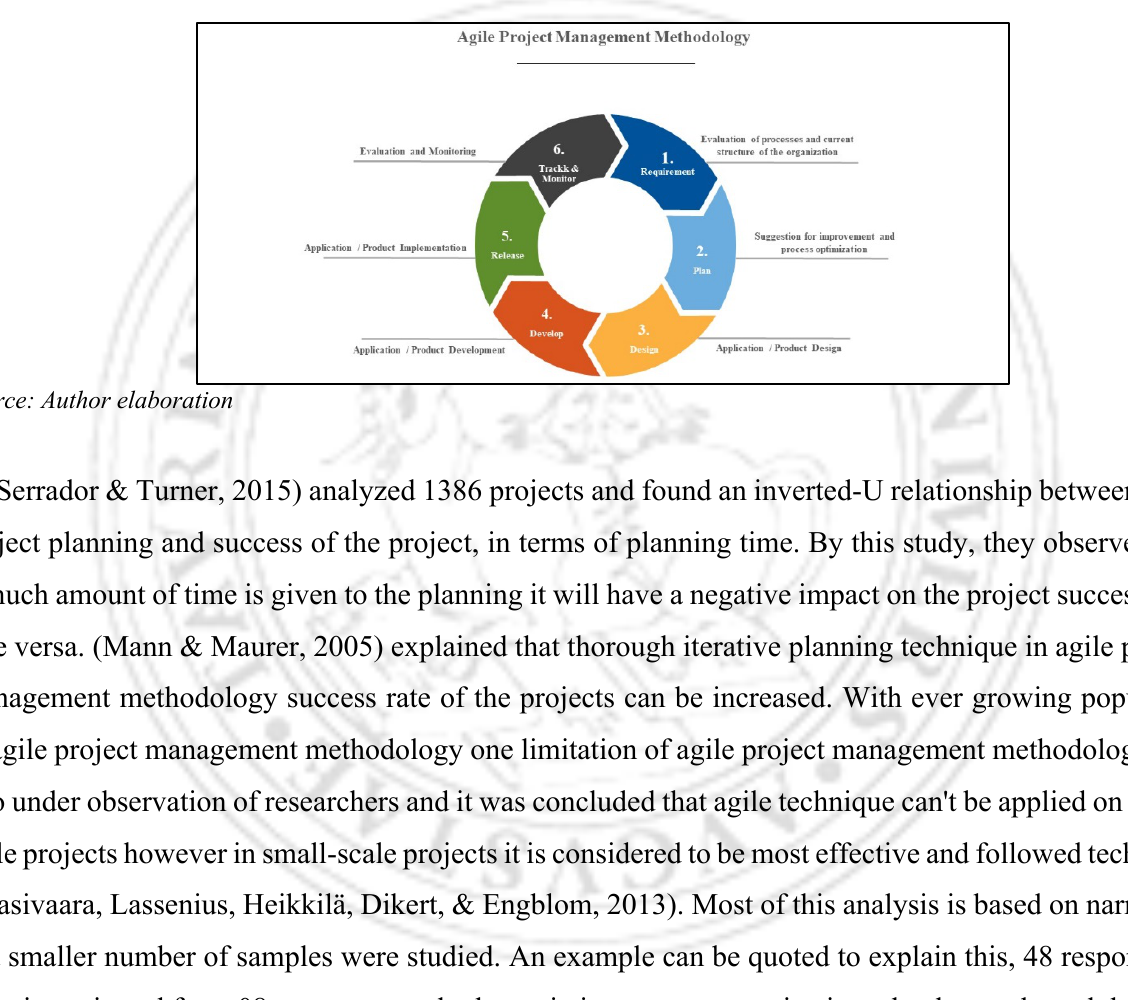
Figure 2 Agile Project Management